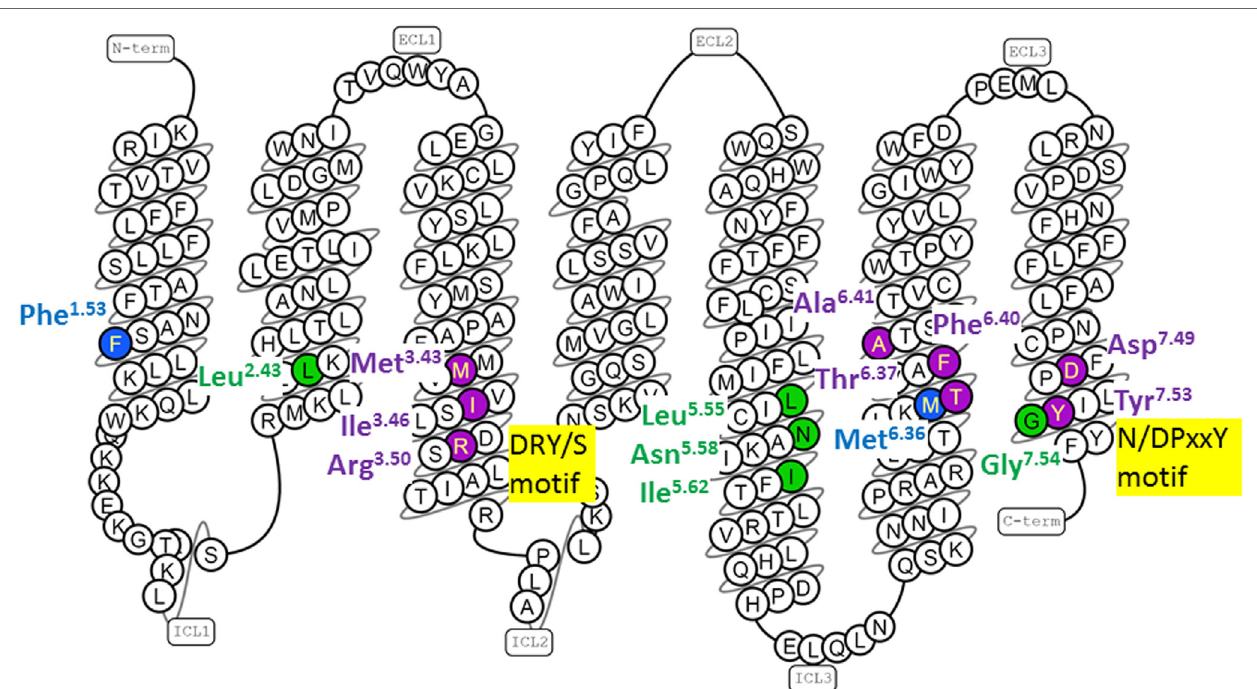
FiGURe 2 | Human gonadotropin-releasing hormone (GnRH) receptor residues topologically equivalent to G protein-coupled receptor (GPCR) residues that form conserved conformation-specific interhelical contacts. The snake diagram of the GnRH receptor amino acid sequence was downloaded from GPCRdb (www. gpcrdb.org/structure/homology_models) (71). GnRH receptor residues topologically equivalent to residues that form conserved conformation-specific contacts (17, 19) only in inactive GPCR structures (blue); only in active GPCR structures (green) and with different partners in inactive and active GPCR structures (purple) are